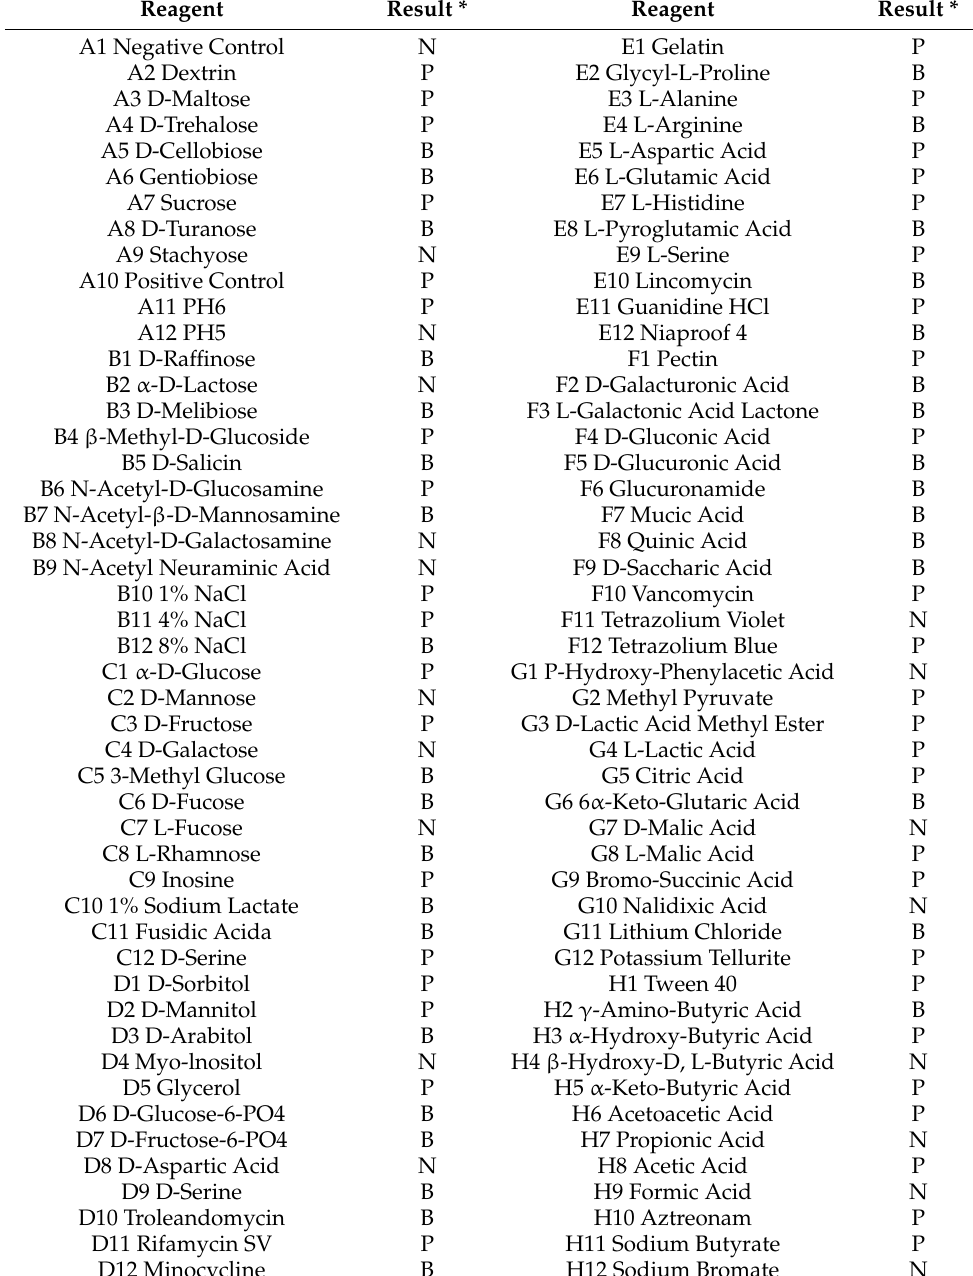
Table 1. Biochemical identification results of strain